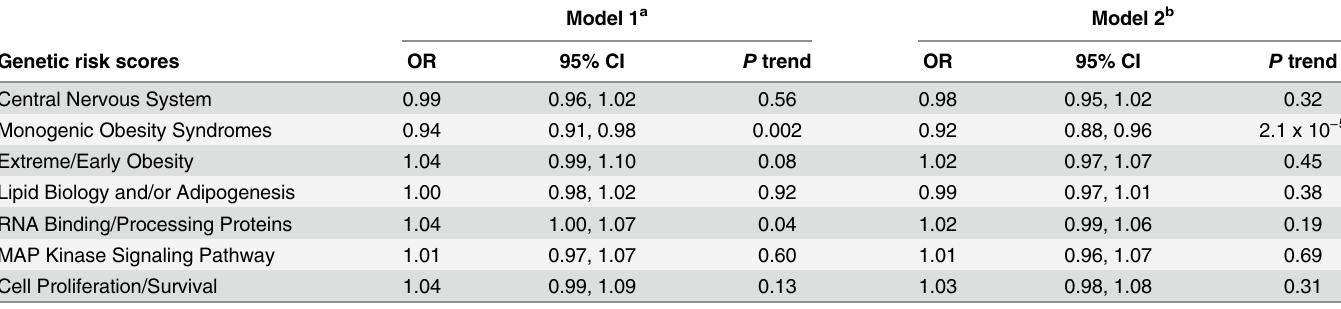
Table 3. Genetic Risk Scores Based on Biologic Single Nucleotide Polymorphism Subsets and Endometrial Cancer Risk Among Women of Euro- pean